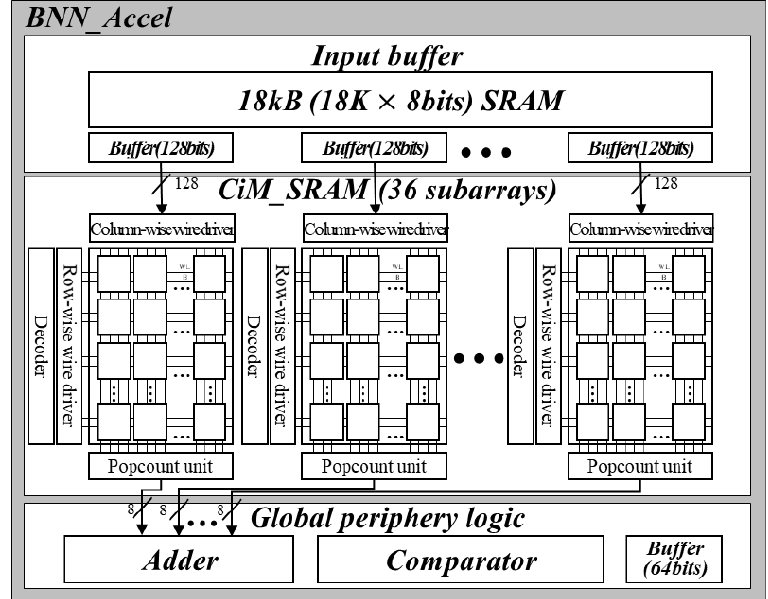
Figure 3. Overall structure of BNN_Accel .